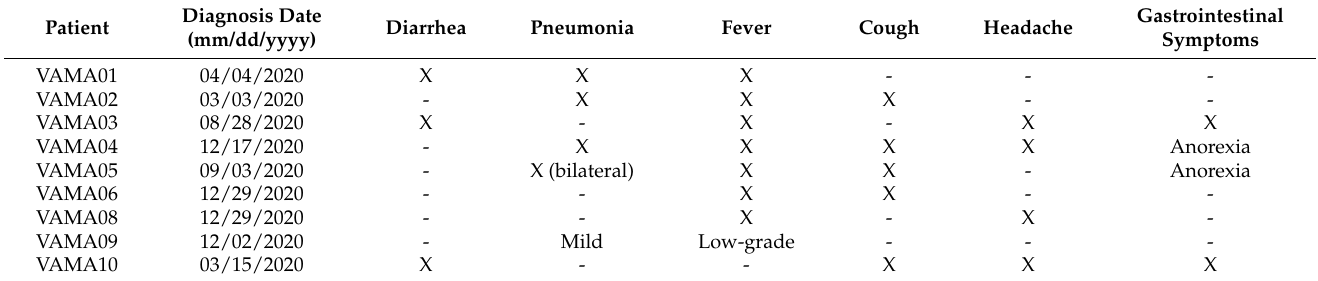
Table 3. Clinical picture upon